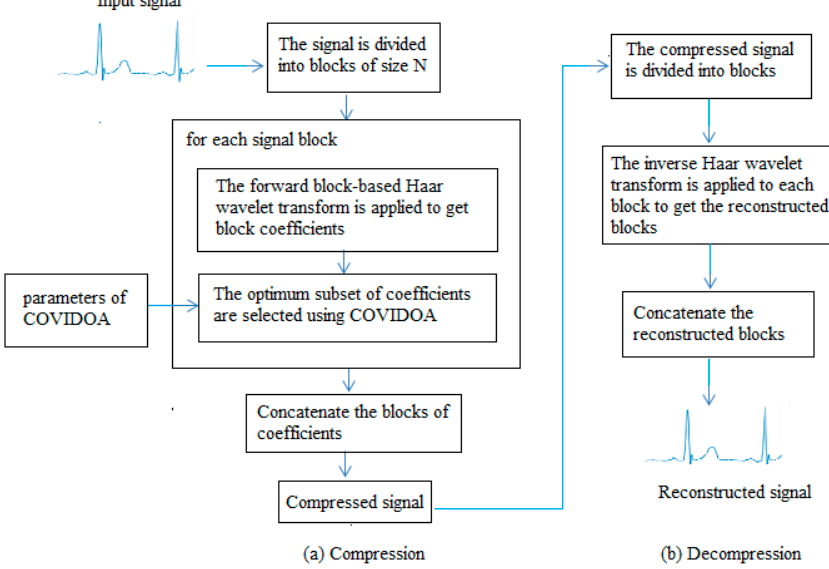
Figure 3. Compression and Decompression processes of the suggested algorithm.